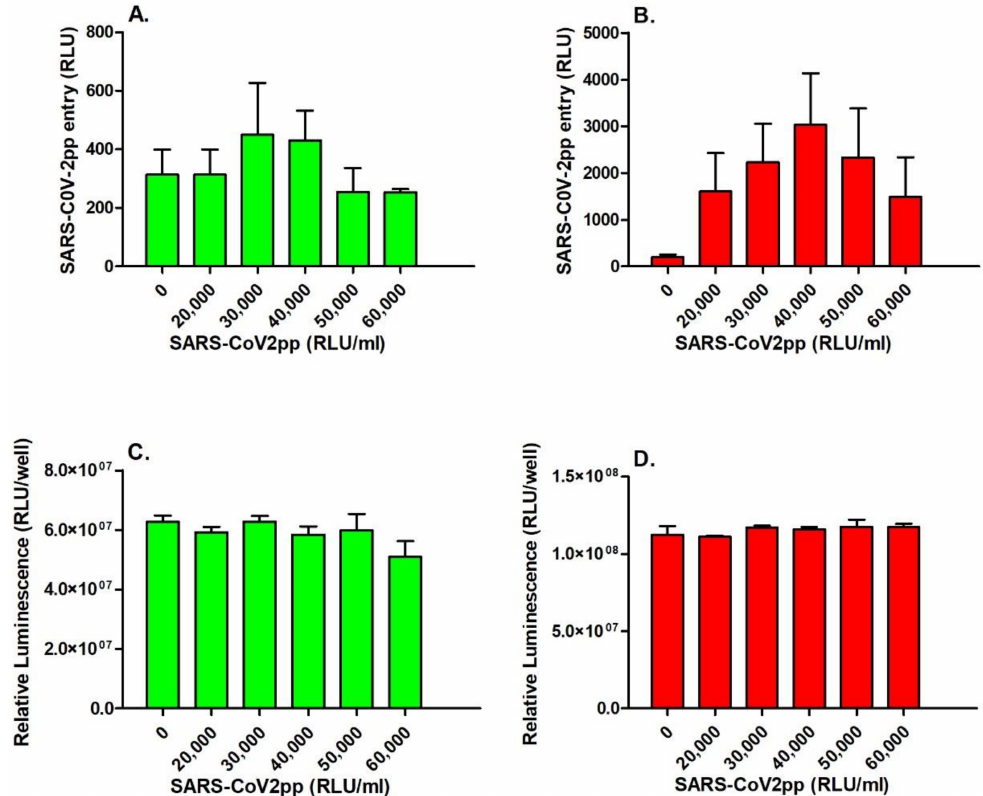
Figure 2. SARS-CoV-2pp enter the cells in a dose-dependent manner without altering cell viability. Vero E6 and Huh7 cells were infected with increasing doses of SARS-CoV-2pp (RLU/mL). At 48 h p.i., SARS-CoV-2pp entry into cells was assessed by a luciferase activity assay (RLUs) in Hu7 cells ( A ) and Vero E6 cells ( B ), and cell viability was measured by a luminescence assay for quantification of ATP levels in metabolically active Hu7 ( C ) and Vero E6 cells ( D ). Data for cell viability are expressed as relative luminescence units (RLUs). Values are plotted as the mean ±